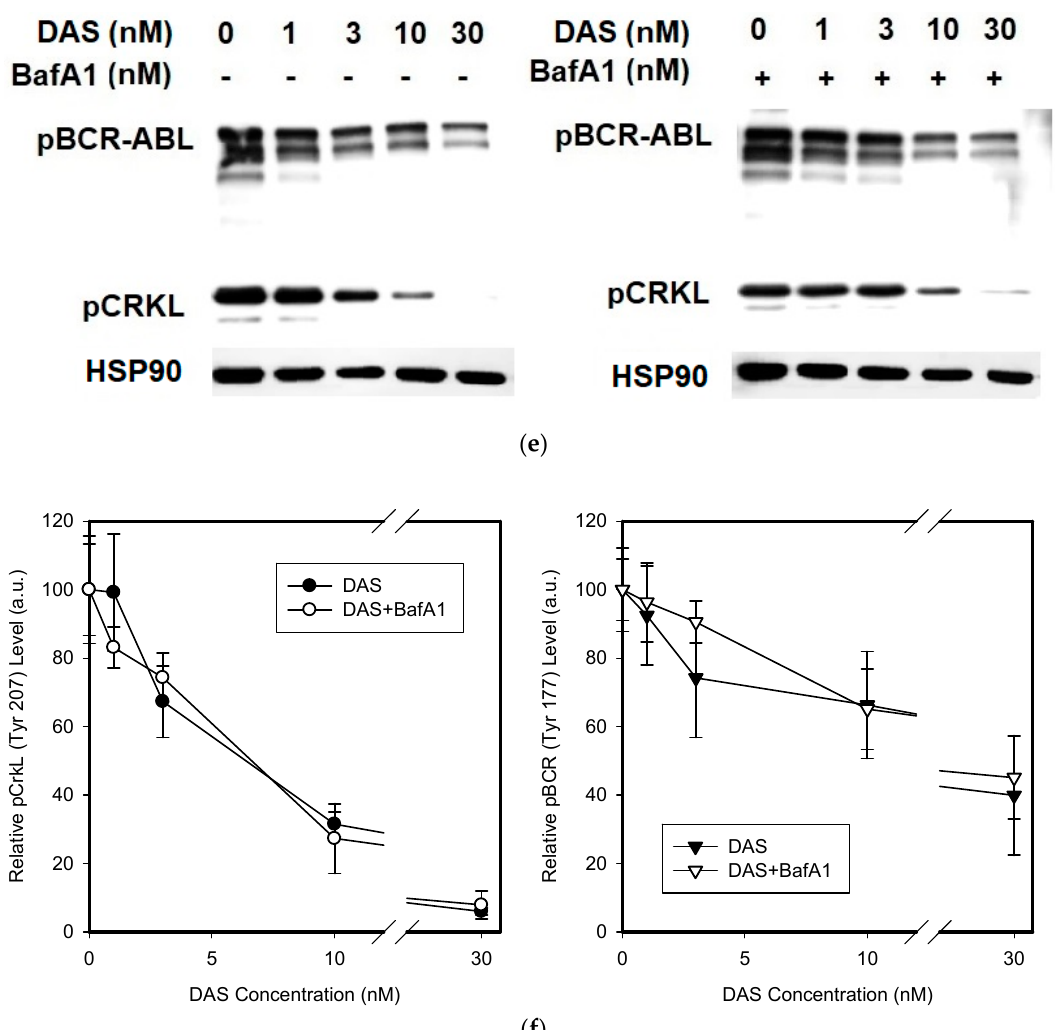
Figure 4. The effect of the lysosomal sequestration of TKIs on the inhibition of Bcr-Abl signaling. Cells were incubated with various TKI concentrations in the absence or presence BafA1. After 6 h, cell extracts were analyzed for CrkL phosphorylation (Tyr207) and Bcr-Abl phosphorylation (Bcr (Tyr177)) using western blot analysis. ( a ) Cells incubated wit IM ± BafA1 (typical analysis). ( b ) Quantitative analysis of western blots using densitometry. ( c ) Cells incubated wit NIL ± BafA1 (typical analysis). ( d ) Quantitative analysis of western blots using densitometry. ( e ) Cells incubated wit DAS ± BafA1 (typical analysis). ( f ) Quantitative analysis of western blots using densitometry. Columns represent the means and standard deviations of four independent experiments.